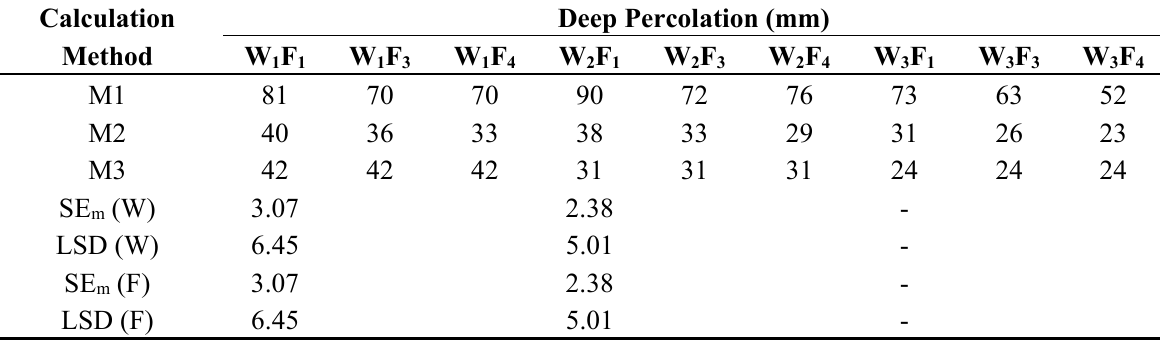
Table 5. Deep percolation for all treatments during the wheat growing season of